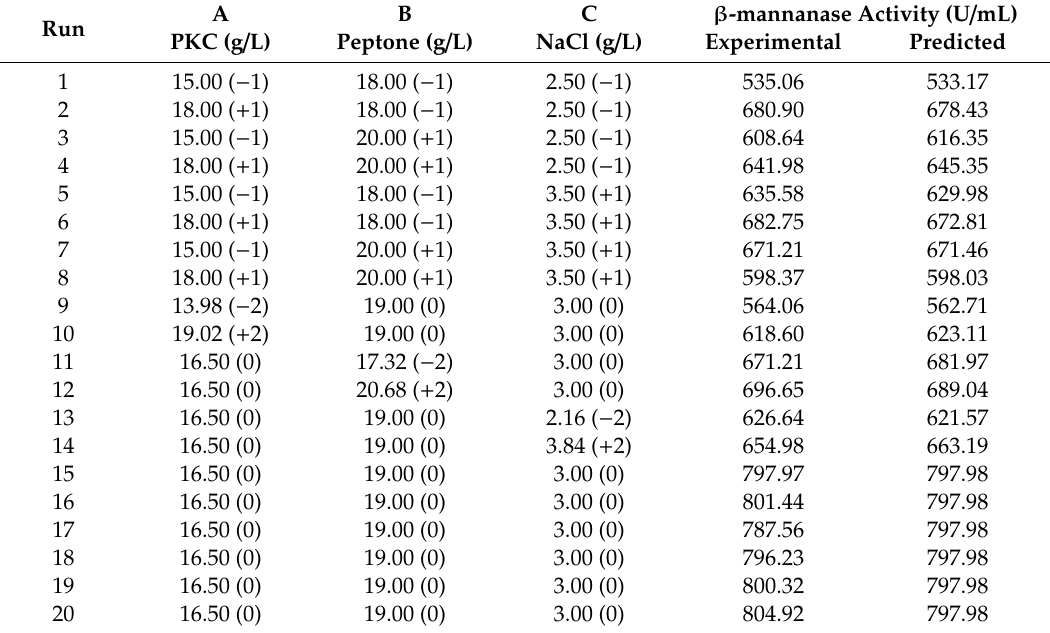
Table 5. Full factorial CCD matrix for the three significant variables and experimental and predicted β -mannanase production by B. subtilis ATCC